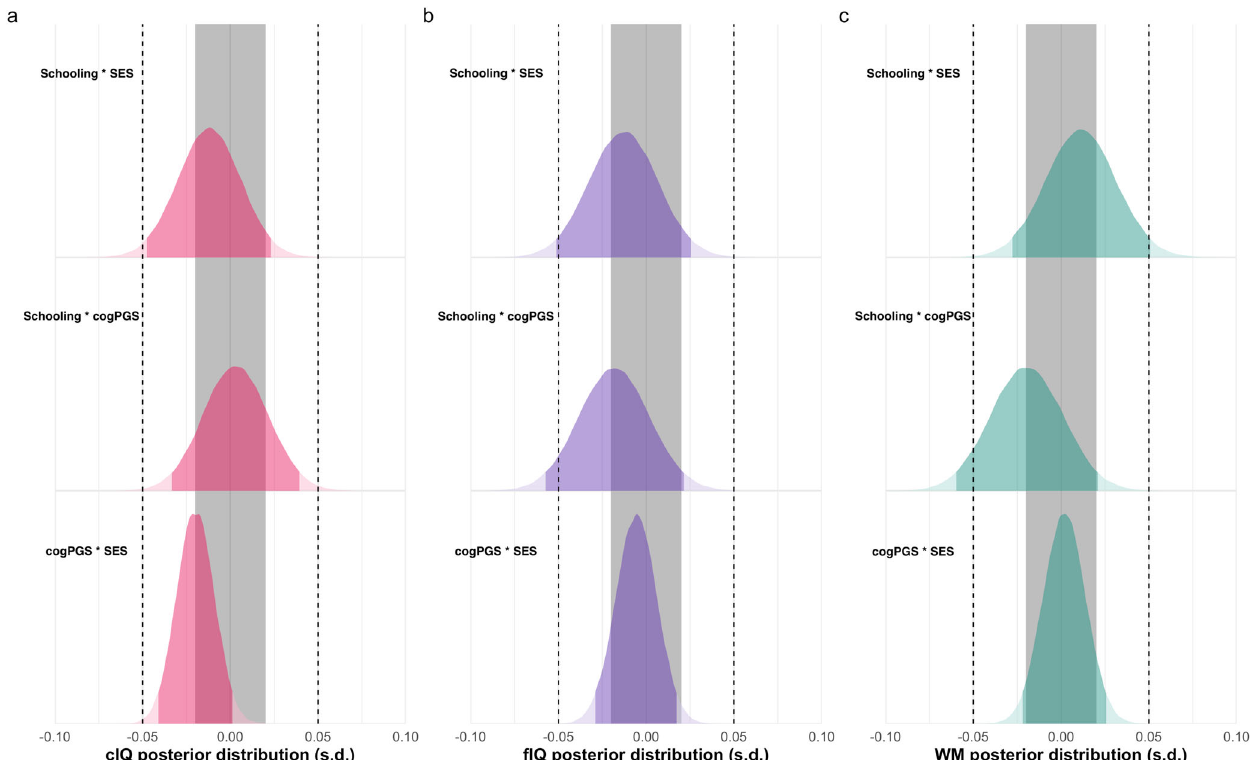
Fig. 3 Interaction effects for cognition. The estimated interaction effects of schooling-SES, schooling-cogPGS and cogPGS-SES on a cIQ, b fIQ, and c WM from a hierarchical Bayesian mixed-effects model. All values are in standard units. Dark blue shading indicates the 95% highest-density interval ’ s (HDI) of the estimates posterior distribution. The gray band represents a region of practical equivalence (ROPE) of 0.02 SD ’ s, while the dotted lines indicate a ROPE boundary of 0.05 SD ’ s. Most of the interaction terms are fully within a 0.05 SD ROPE boundary providing evidence for the null hypothesis at this boundary, yet none fully lie within a ROPE boundary of 0.02 SD ’ s (Supplementary Table